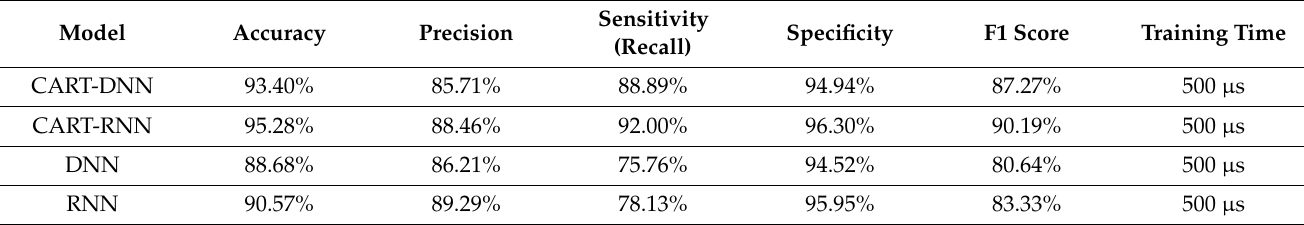
Table 13. Summary of confusion matrix indicators of all